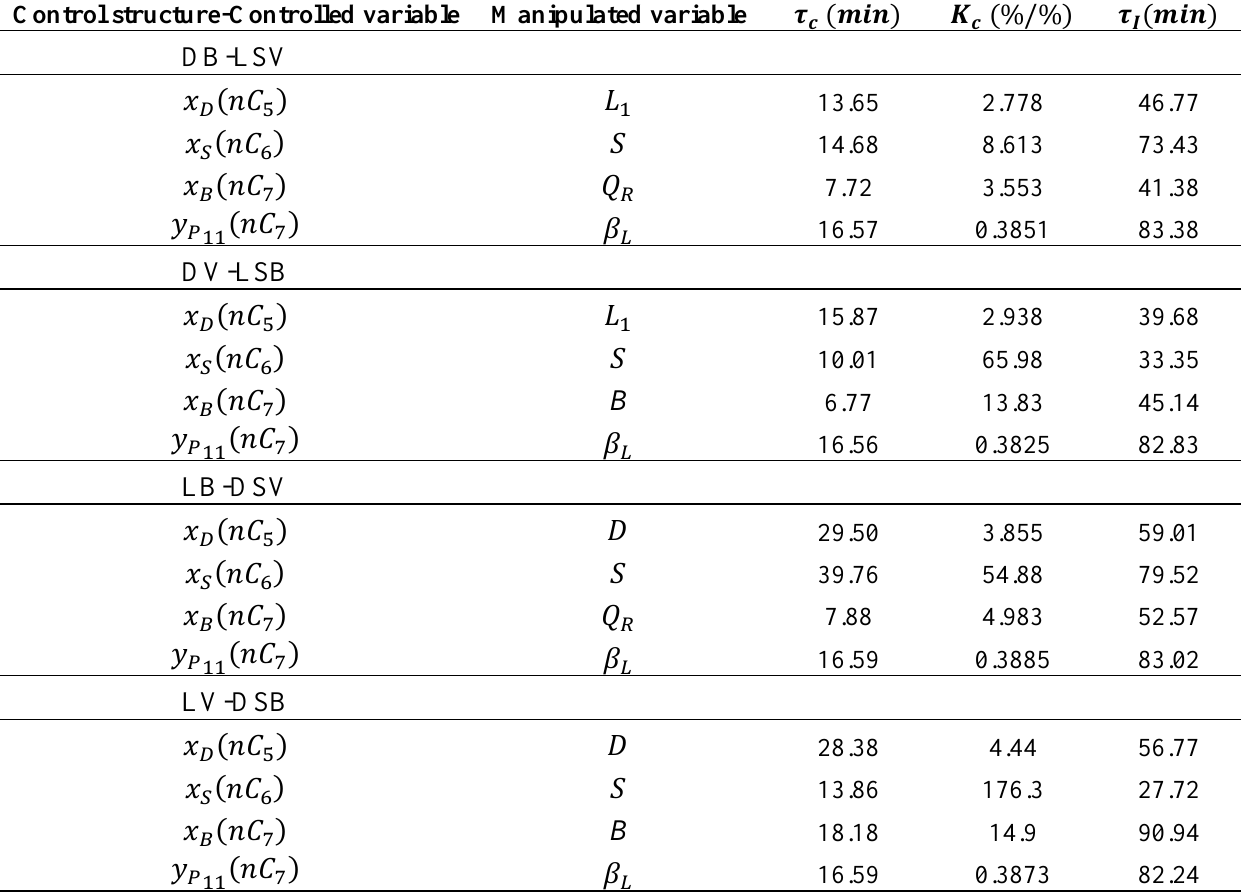
Table 4. Parameter values of the PI controllers obtained using IMC tuning. Control structure-Controlled